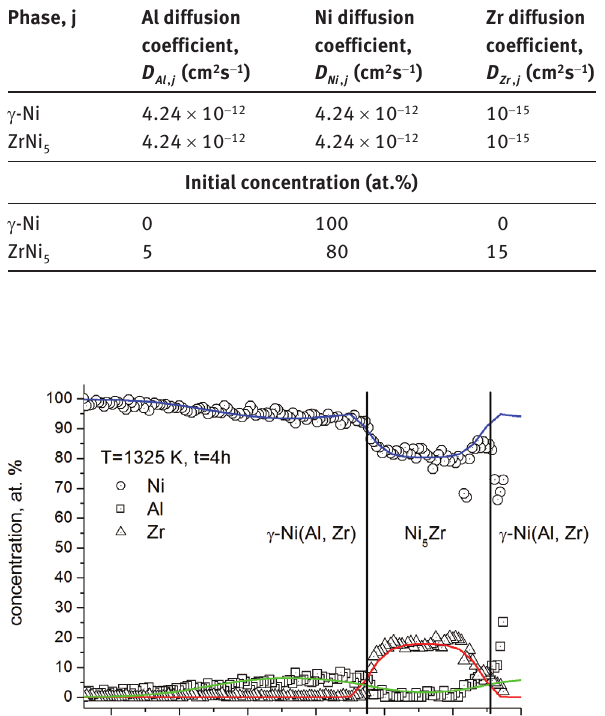
Table 4: Thermodynamic and kinetic data used to simulate the reactions in Ni-Al-Zr system at 1325 K. Phase, j